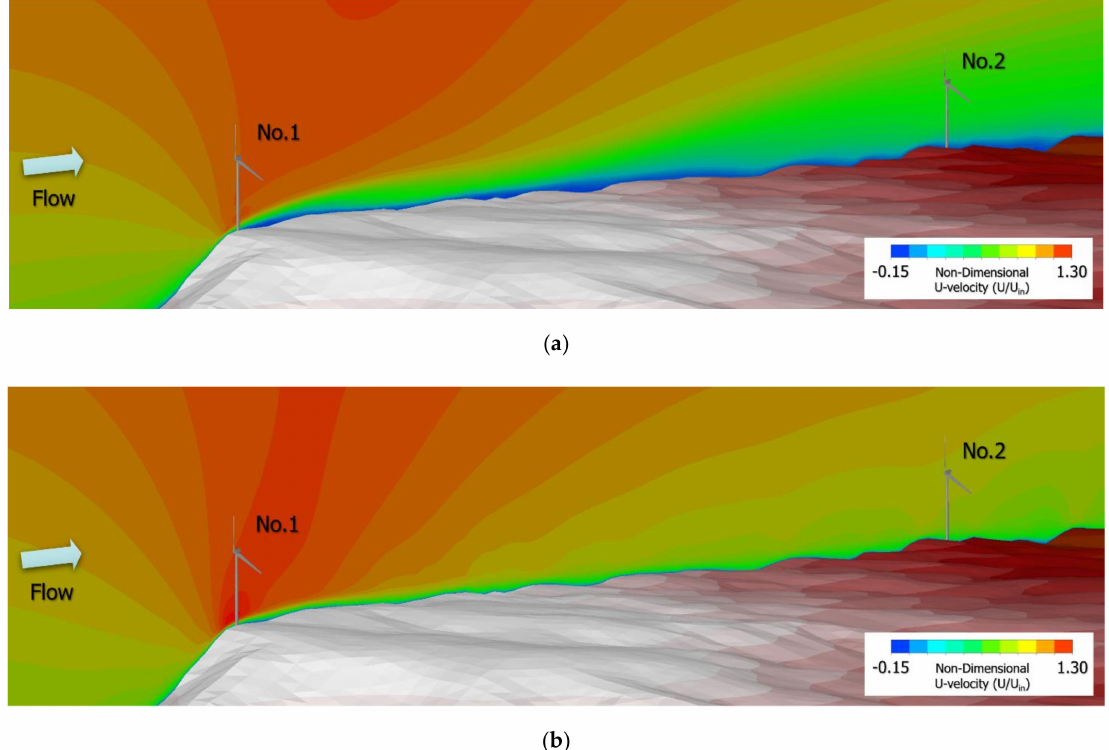
Figure 22. Time-averaged flow field, including the No. 1 and No. 2 wind turbines and the spatial distribution of the corresponding U-velocity. ( a ) Neutrally stratified condition (Ri = 0.0); ( b ) Stable stratified condition (Ri = +